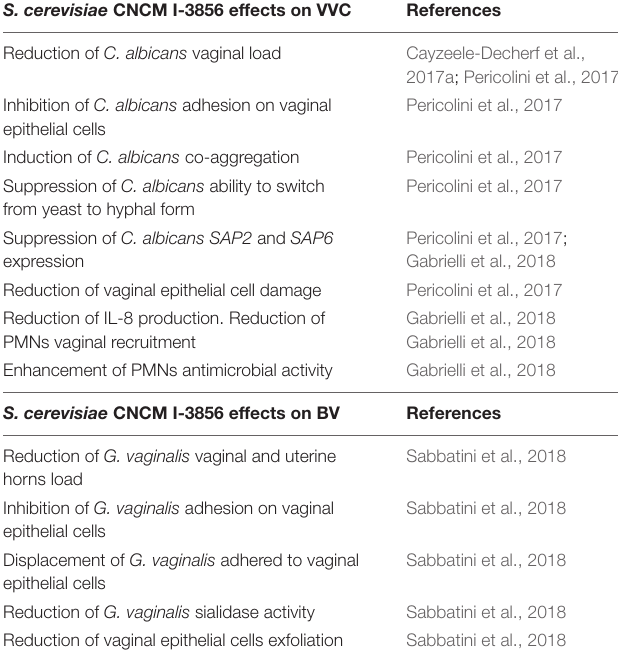
TABLE 1 | Effect of S. cerevisiae CNCM I-3856 on vaginal